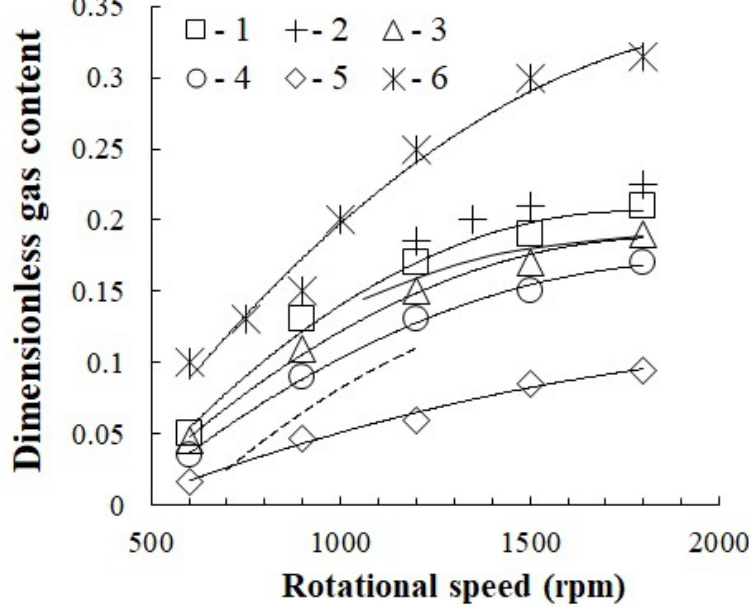
Figure 9. Dependence of gas content on the rotational speed of the stirrer at a water temperature of 23 °С, D = 0.28 (m), d s = 0.064 (m), H L / D = 1.2, h = 0.3 (m). Experimental points (1–6): 1—two partitions; 2—one partition, H L / D = 3; 3—one partition; 4—three partitions; 5—one partition, h = 0.05 (m); 6—one partition, 10% glycerin– water. The dotted line is the data from Poncin, S. et al., 2002 [7].